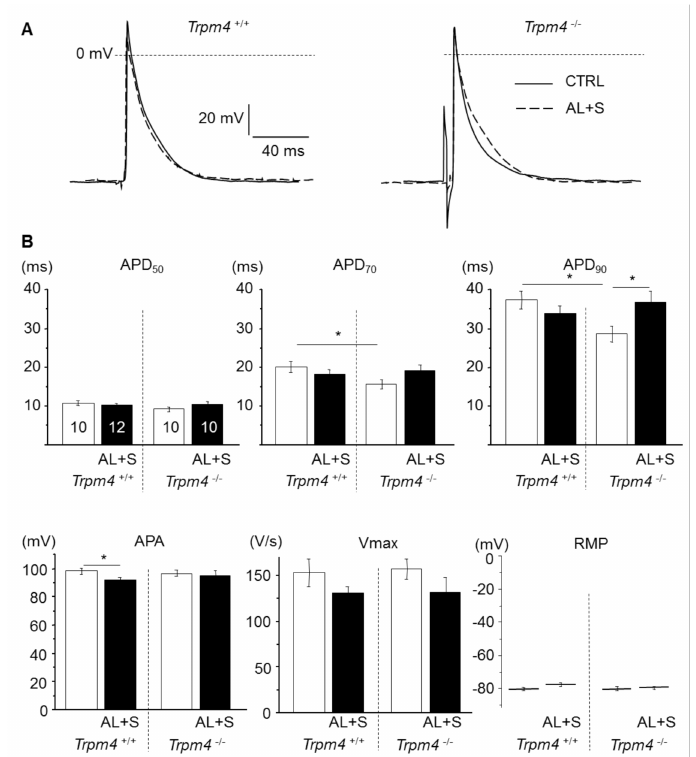
Figure 2. Effect of aldosterone + salt treatment on atrial action potential. ( A ) Representative action potentials (AP) from isolated left atrium recorded using intracellular microelectrodes for Trpm4 +/+ (left) and Trpm4 -/- (right) animals, stimulated at 5 Hz. For each group, action potential from an aldosterone treated animal (dotted trace) is overlaid to a control animal (solid trace). ( B ) Mean AP parameters for each group (numbers of animals are indicated in the APD 50 graph and are similar for other graphs). APD 50, 70, 90 (action potential duration at 50, 70, and 90% repolarization); APA (action potential amplitude); V max (upstroke maximal velocity); and RMP (resting membrane potential). Statistical significance between groups are indicated by